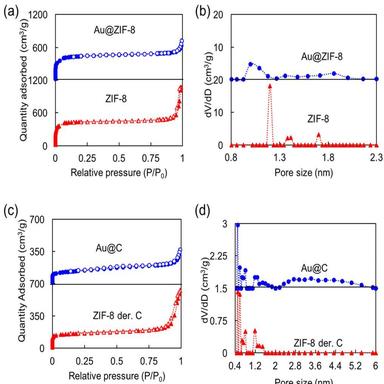
(a) Nitrogen adsorption/desorption of Au@ZIF-8 and ZIF-8. (b) Pore size of Au@ZIF-8 and ZIF-8. (c) Nitrogen adsorption/desorption of Au@NC and ZIF-8 derived carbon. (d) The pore size of Au@NC and ZIF-8 derived carbon. Reprinted with permission from Ref. .